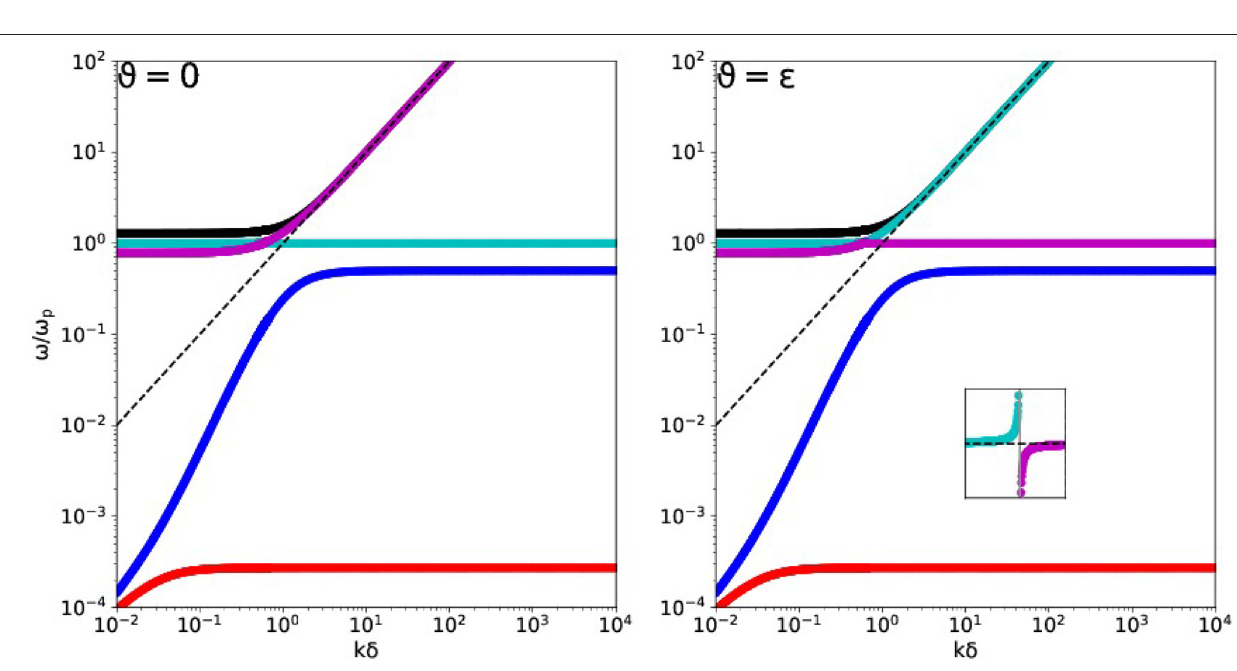
FIGURE 4 | Dispersion diagram for a hydrogen ion-electron plasma at E propagation. The latter shows avoided crossings (see inset). The dashed black line corresponds to light speed behavior.